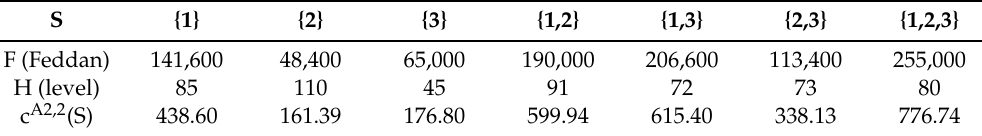
Table 7. The calculated costs for game c A2,2 .